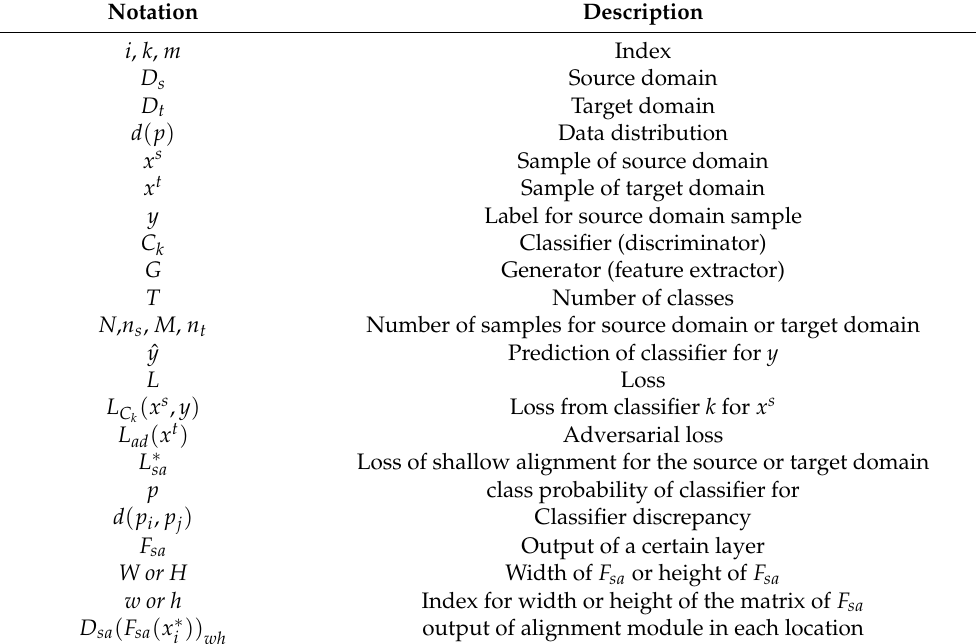
Table 1. Notations in this work.